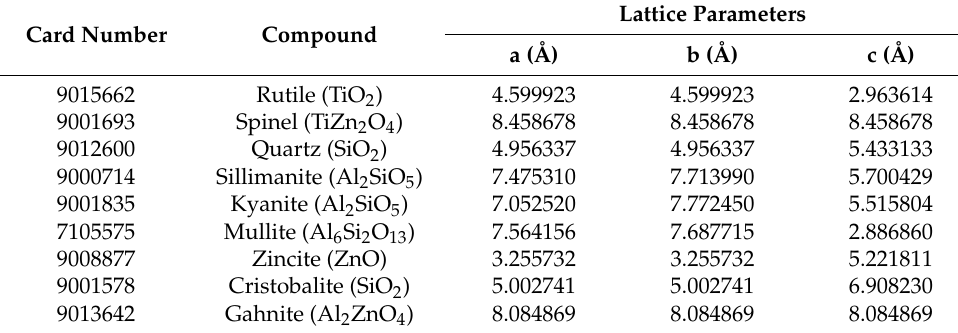
Figure 2. XRD results of materials containing varying amounts of Al 2 O 3 (a.u. stands for arbitrary units). Table 2. Lattice parameters and DB card numbers of the